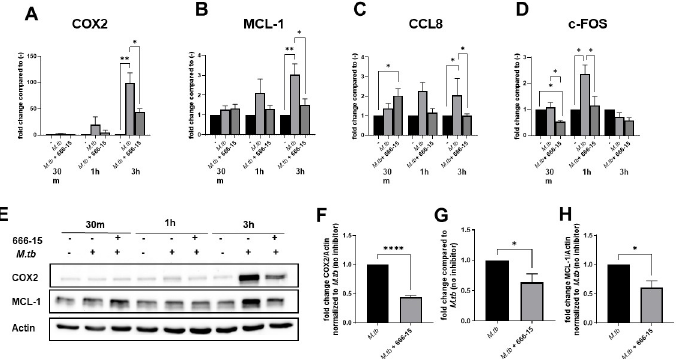
Fig 3. M . tb -induced CREB activation is important for induction of immediate early genes in human macrophages. MDMs were pretreated with DMSO or 666–15 for 60 min and subsequently infected with M . tb H 37 R v at the MOI 10 (A-F,H) by synchronized phagocytosis or MOI 5(E). RNA or protein lysates were collected at the indicated time points. A-D) Gene expression of COX2, MCL-1, CCL8 and c-FOS was determined by qRT-PCR and data are shown as fold change ± SEM compared to uninfected MDMs. Data are cumulative of n = 3–5 donors. One-way ANOVA with Tukey’s post-test. E) Cell lysates were probed by WB for COX2, MCL-1 and β -actin. A representative experiment is shown of n = 3–4 donors. F,H) Densitometry at 3h post infection compared to M . tb -infected MDMs. Data are cumulative ± SEM of n = 3–4 donors. Unpaired t test. G) PGE 2 production was measured by competitive binding ELISA at 6h post infection. Data are cumulative ± SEM of n = 4 donors. Unpaired t test; * p < 0.05, ** p < 0.01, **** p <